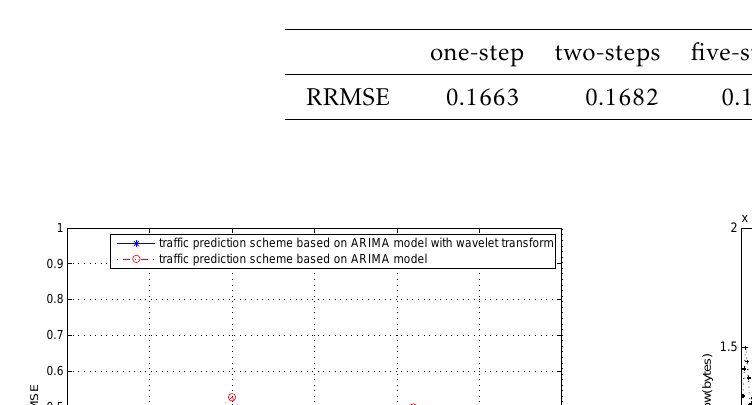
Table 3. RRMSE of different predicted steps